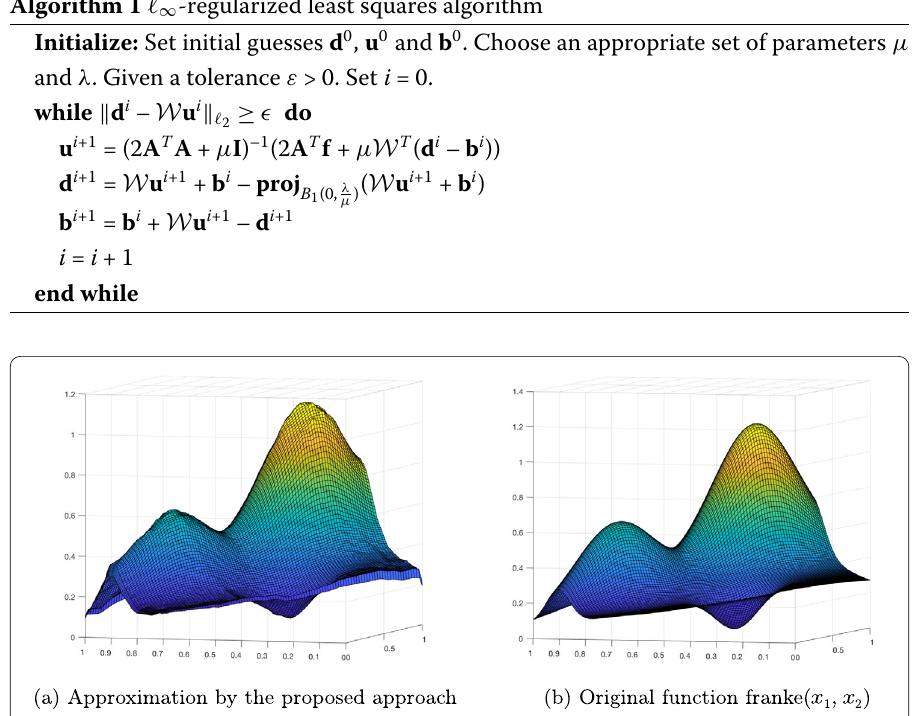
Algorithm 1 (cid:4) ∞ -regularized least squares algorithm